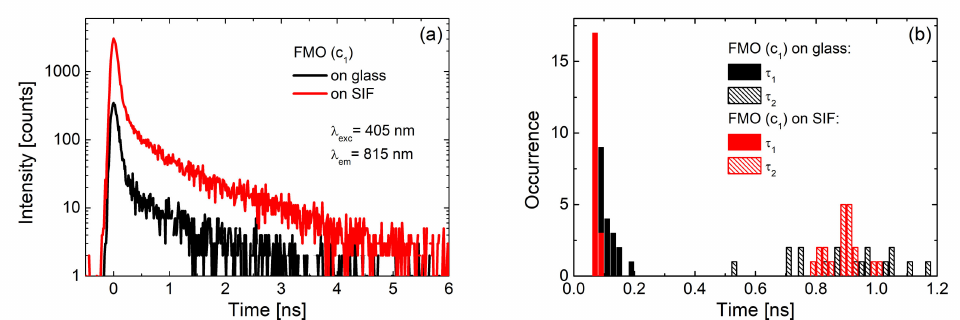
Figure 6. Results of time-resolved experiments for the c 1 concentration of FMO: ( a ) fluorescence decay curves of FMO on glass (black) and on SIF (red) and ( b ) histograms of fluorescence lifetimes of FMO deposited on glass (black bars) and on SIF (red